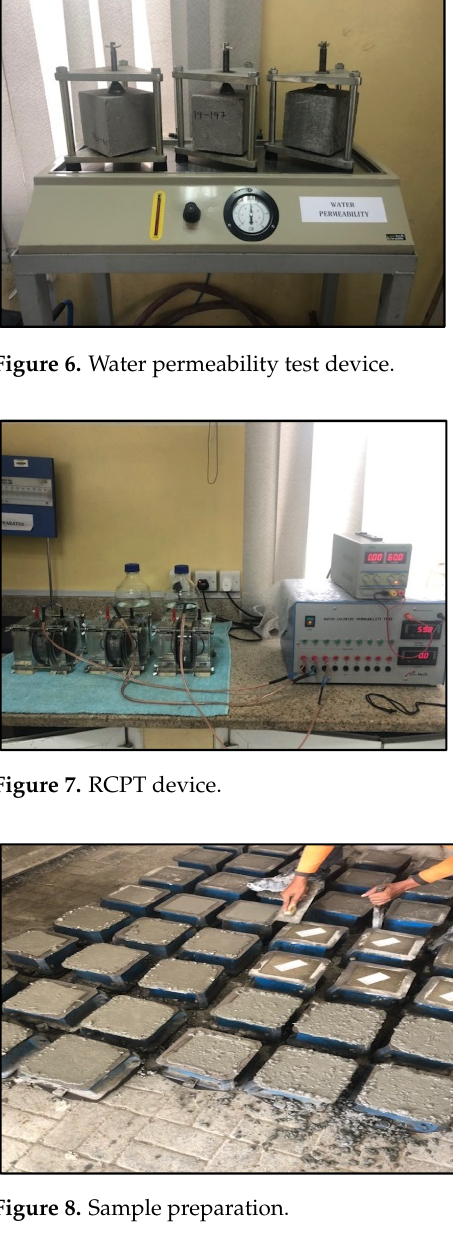
Figure 5. Water absorption test device.